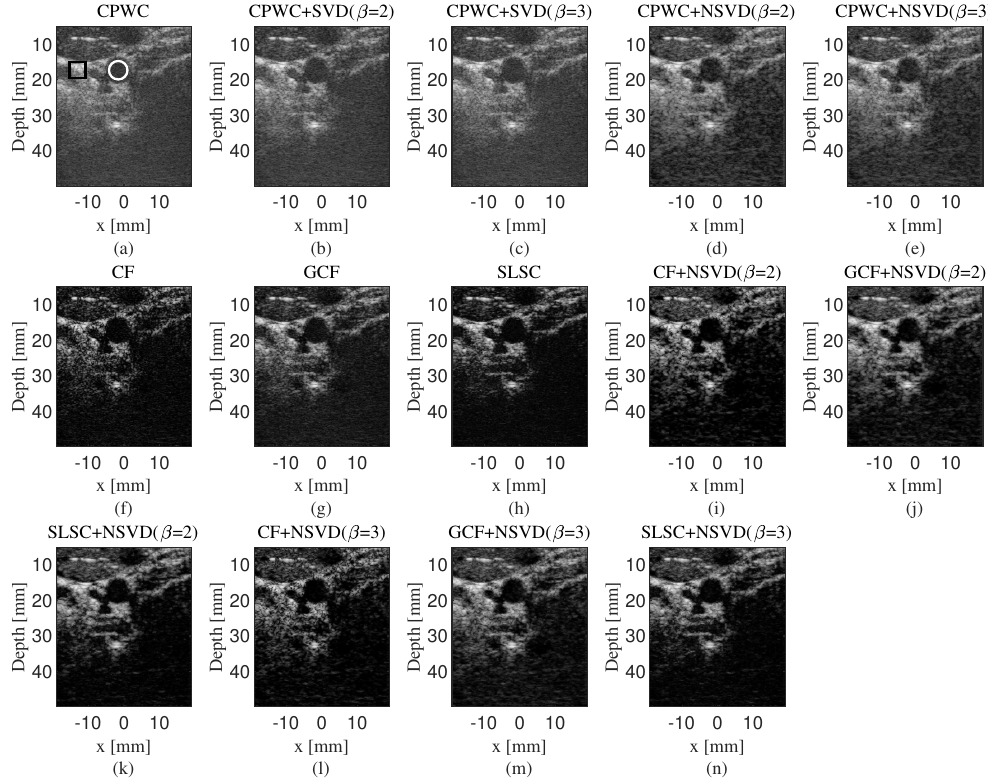
Figure 14. B-mode in vivo images formed by different methods. ( a ) CPWC, ( b ) CPWC+SVD ( β = 2), ( c ) CPWC+SVD ( β = 3), ( d ) CPWC+NSVD ( β = 2), ( e ) CPWC+NSVD ( β = 3), ( f ) CF, ( g ) GCF, ( h ) SLSC, ( i ) CF+NSVD ( β = 2), ( j ) GCF+NSVD ( β = 2), ( k ) SLSC+NSVD ( β = 2), ( I ) CF+NSVD ( β = 3), ( m ) GCF+NSVD ( β = 3), ( n ) SLSC+NSVD ( β = 3). A circular region inside the carotid artery and a rectangular region outside the carotid artery are marked and used to calculate CR, CNR, gCNR, and sSNR.